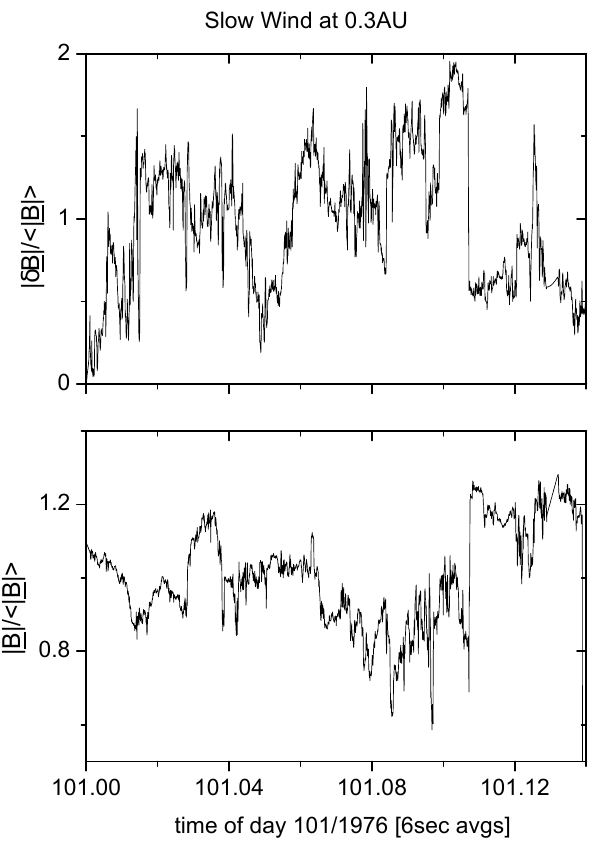
Fig. 4. Data refer to a slow wind at 0.3AU. Top panel: vector dis- placement | δB(t) | , normalized to < | B | > , between each B(t) and an arbitrary fixed direction versus time. The arbitrary direction was chosen as the direction of the first vector of the time series. This kind of graph shows a series of time intervals during which the vec- tor displacement tends to remain approximately close to the aver- age level. These time intervals are interleaved by large and quick directional jumps. Moreover, the largest jumps often coincide with remarkable changes in field intensity as shown in the bottom